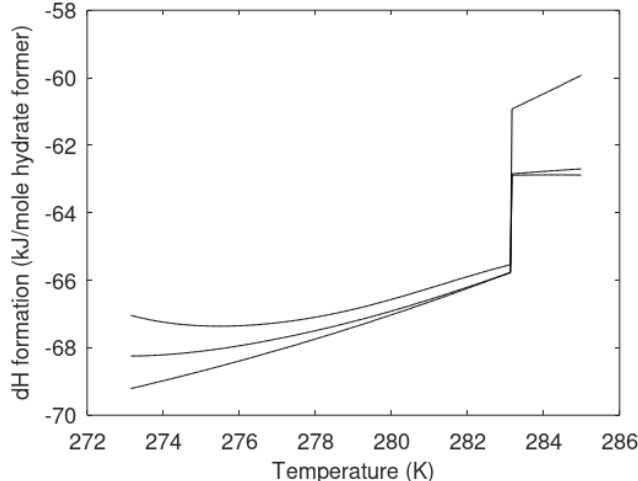
Figure 8. Enthalpies of hydrate formation in kJ/mol hydrate former as function of temperature. For temperatures below the CO 2 phase transition (around 283.5 K), the bottom solid curve corresponds to pure CO 2 hydrate; the top solid curve is 20 mol % N 2 in CO 2 /N 2 mix; the middle curve is 10 mol % N 2 in CO 2 /N 2 mix. Above the CO 2 phase transition, the order of the curves is reversed.